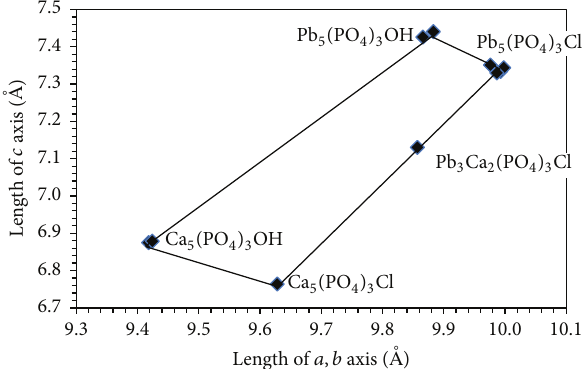
Figure 1: Unit cell graph for apatites containing calcium, lead, hydroxide, and chloride ions (see text for